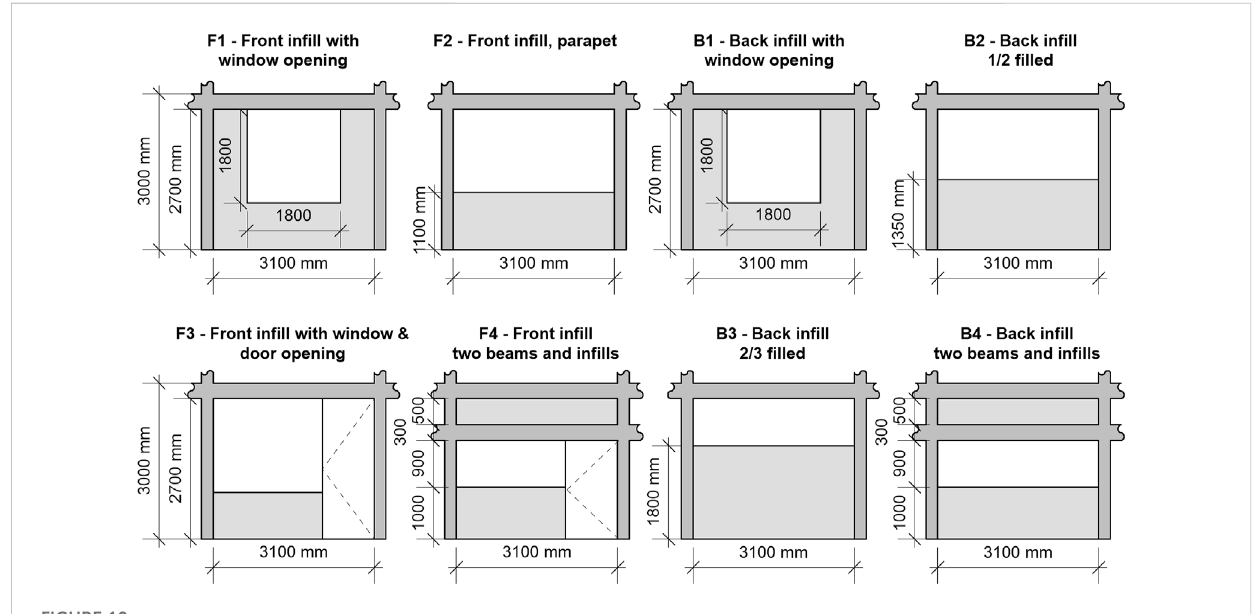
FIGURE 10 Front and rear in fi ll con fi gurations (nominal dimensions; B0: bare